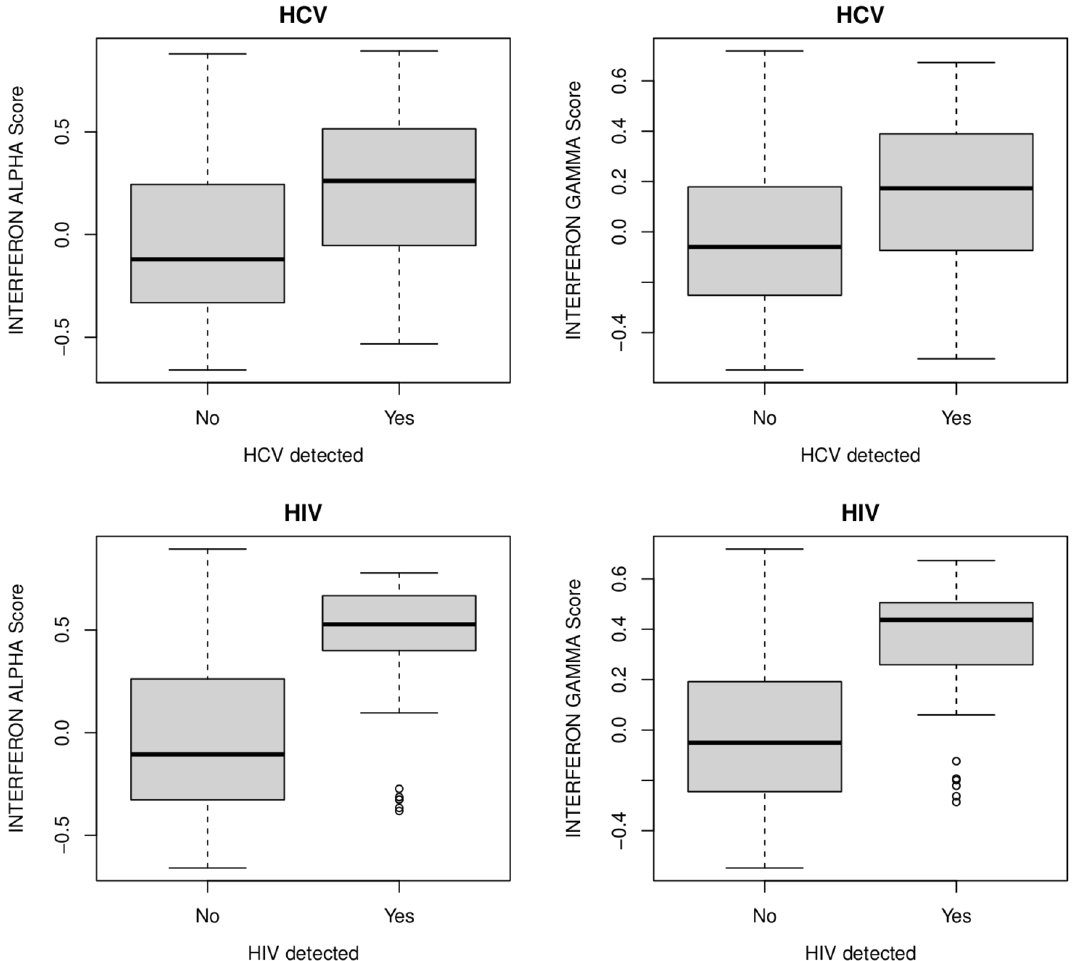
Figure 1. Box plots of the interferon alpha and interferon gamma transcriptomic scores calculated using gene set variation analysis (GSVA) 25 and the MSigDB Hallmark pathway gene sets 24 for the subjects with and without detected Hepatitis C virus (HCV) or HIV